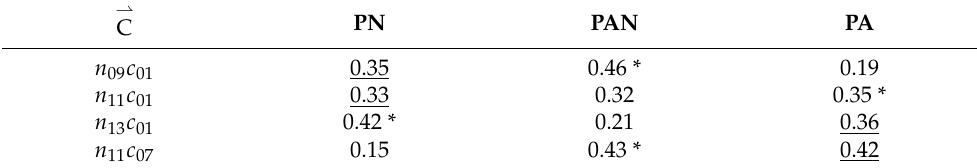
Table 9. Confidence vectors of the four likely misclassified stimulus faces. (cid:42) C PN PAN